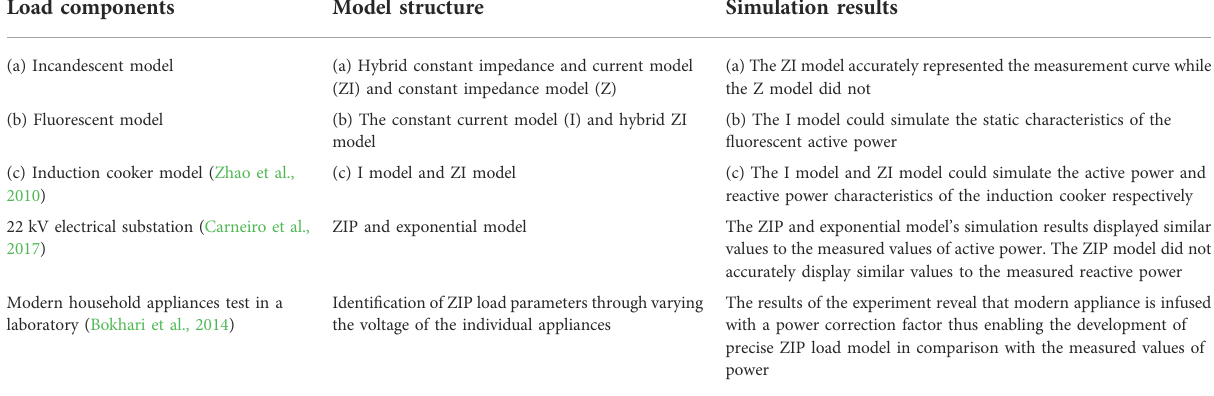
TABLE 6 Examples of modeling of common load components in a microgrid system. Load components Model